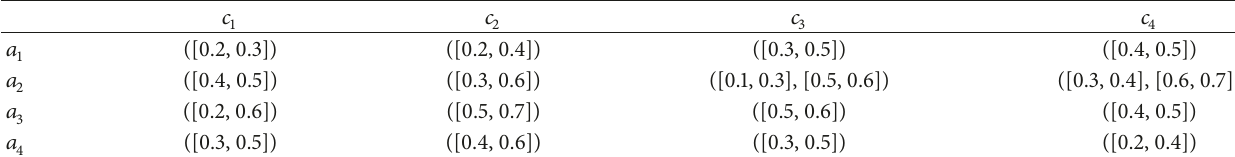
Table 2: The interval-valued hesitant fuzzy matrix 𝐴 2 .